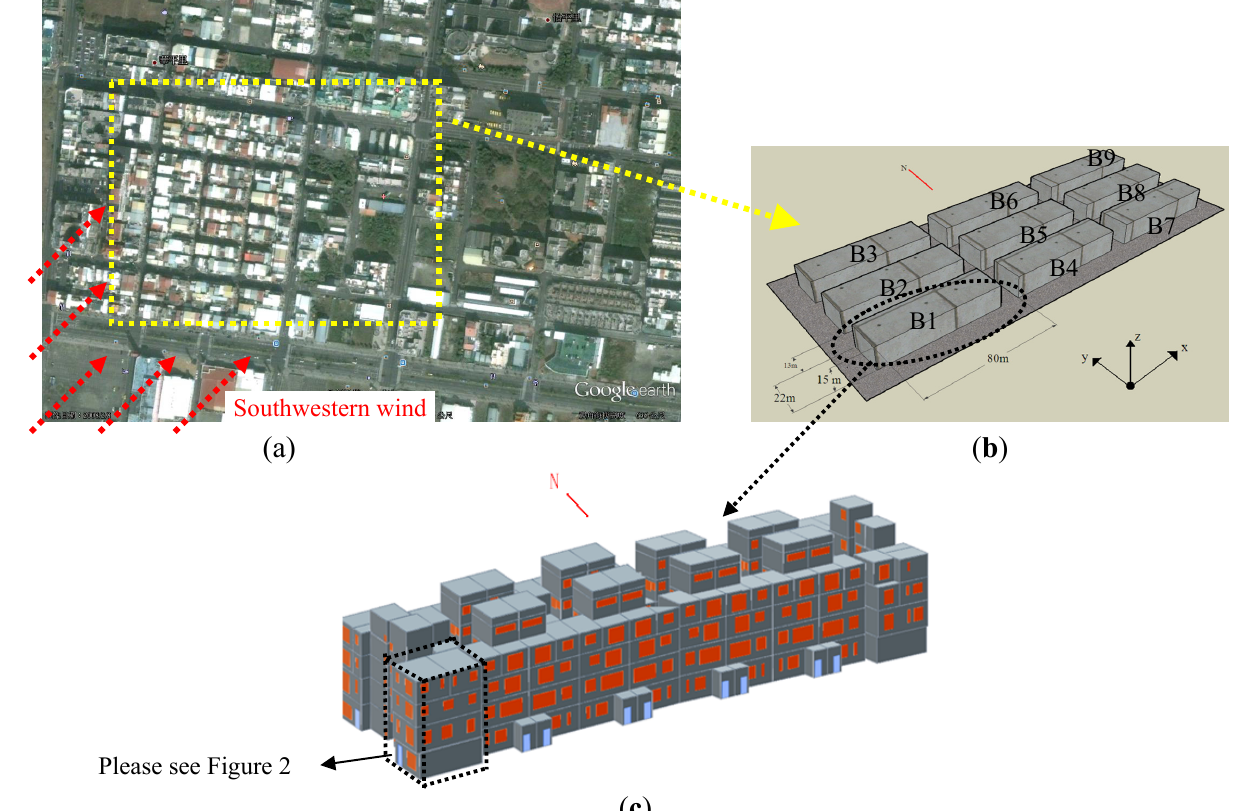
Figure 1. Object of research: ( a ) The area of this research (yellow dotted lines); ( b ) Modified area of research; ( c ) A city block composed by